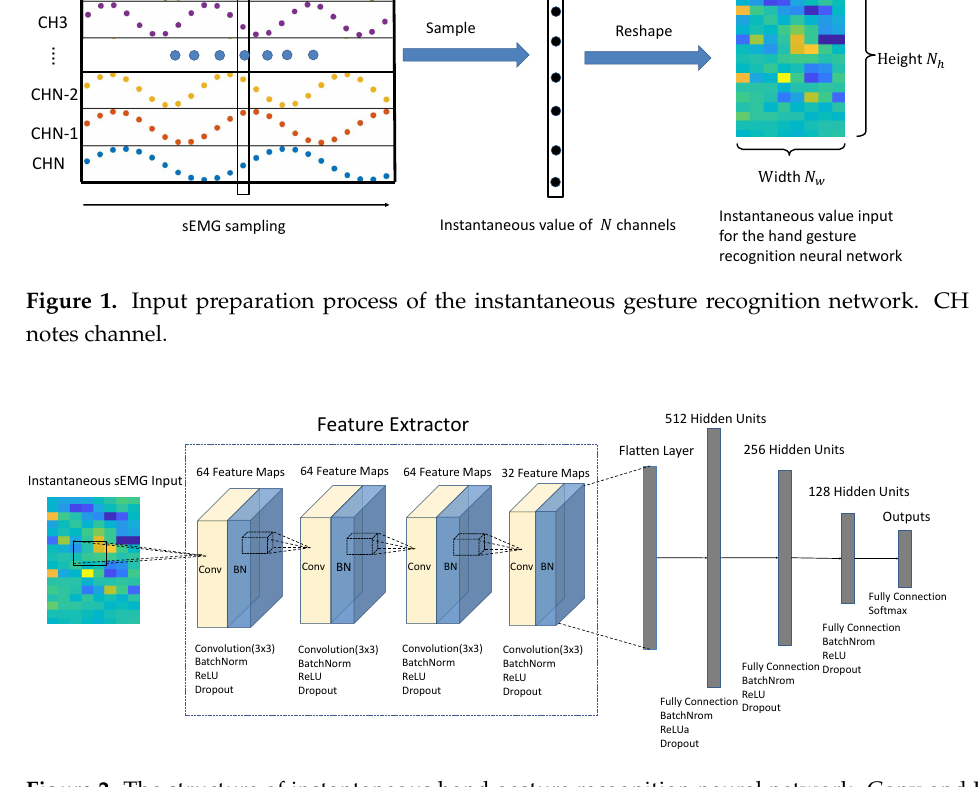
Figure 2. The structure of instantaneous hand gesture recognition neural network. Conv and BN denote Convolution and Batch Normalization,